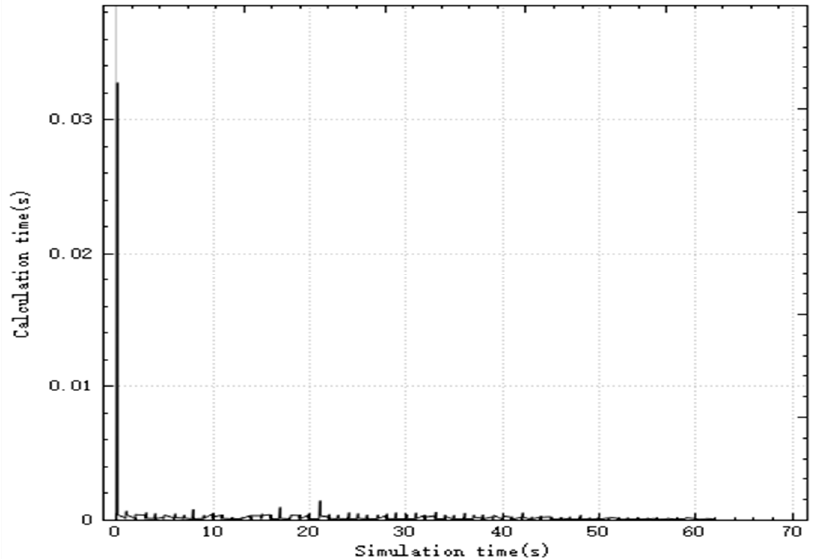
Figure 6. Calculate time-consuming curve in each step.